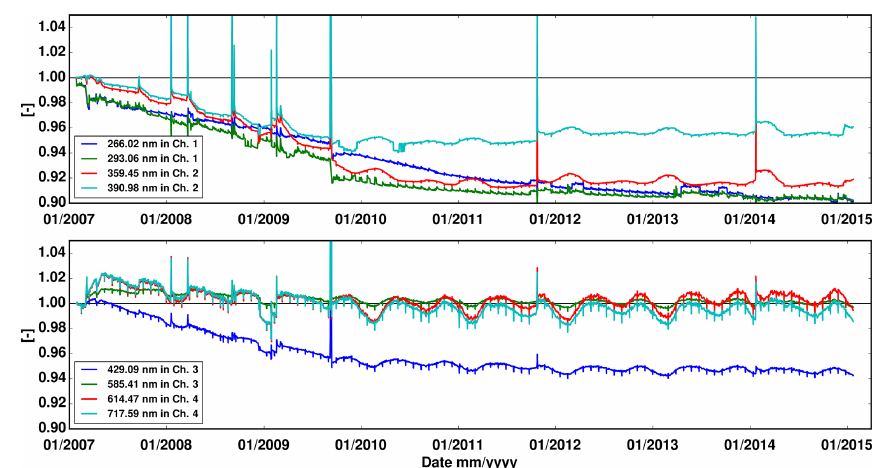
Figure 10. FWHM relative change with respect to January 2007 evaluated from a regular Gaussian fitting of well-separated SLS lines. The upper panel shows the results in channel 1 and 2. The lower panel results for channel 3 and 4.